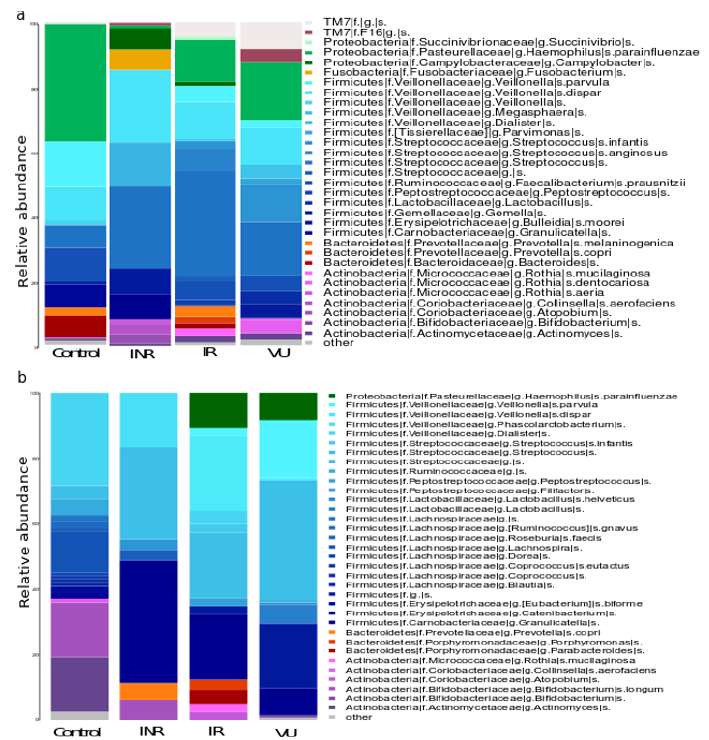
Figure 7. Taxa distribution of co-occurrences in each group: ( a ) at baseline; ( b ) after prebiotics. INR, immunological ART non-responders; IR, immunological ART responders; VU, viremic untreated.